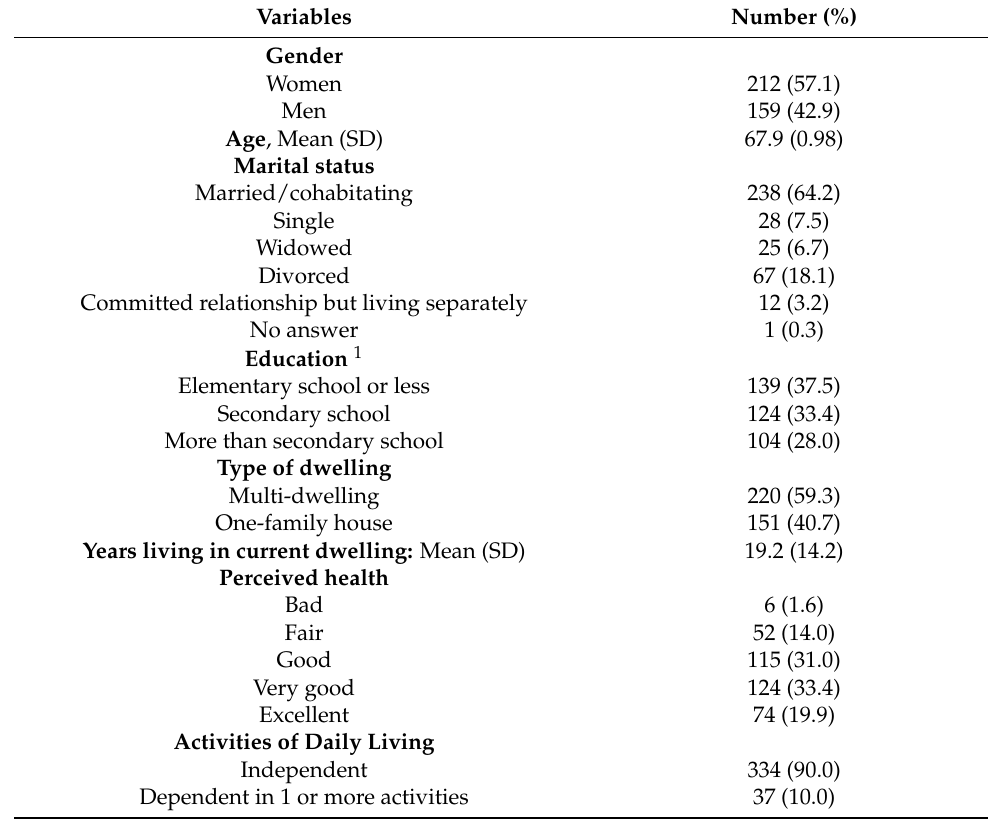
Table 1. Characteristics of the participants (N =